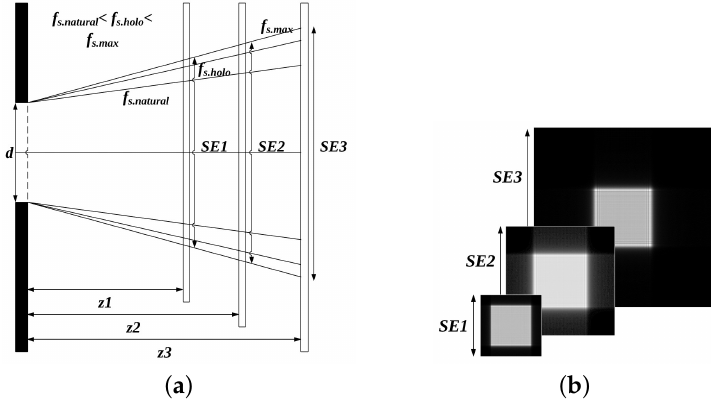
Figure 3. Spatial extent in diffraction plane according to the spatial frequency of the input plane ( a ) relationship between spatial frequency and distance ( b ) visual